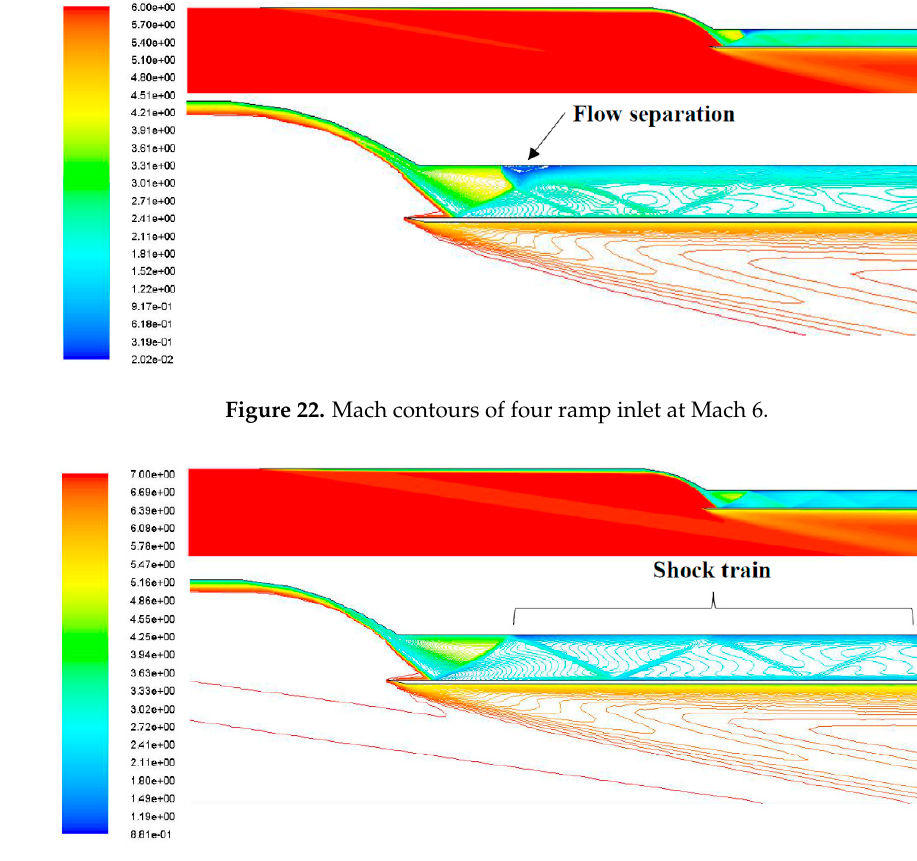
Figure 24. Mach contours of four ramp inlet at Mach 8. The unfilled contour lines allow the identification of the shock waves propagating through the isolator. An expansion fan is produced at the turn after the final ramp, identifiable by the increasing Mach number. Fust after the oblique shock waves the flow decelerates to Mach 3.48. As the flow passes through the shock train, it is decelerated and the flow speed at the isolator is stabilised at around Mach 3.24. This implies that the shock diamond formed at the isolator is relatively weak as the flow does not keep decelerating further. Figure 25 displays the variation of the compression ratio and stagnation pressure recovery along the centreline of the isolator, from just before the shock layer produced by the combination of oblique shock waves for flight at Mach 8. The repeating peak and trough pattern is the result of the shock train, as the reflecting oblique shock wave loses momentum the properties of the flow become stable, ideal for the combustion process. The compression ratio peaked at 54 just after the final oblique shock wave but then averages to 26 in the isolator. This is higher than the 50.35 obtained using empirical equations. The stagnation pressure recovery averaged 8% in the isolator compared to the theoretical